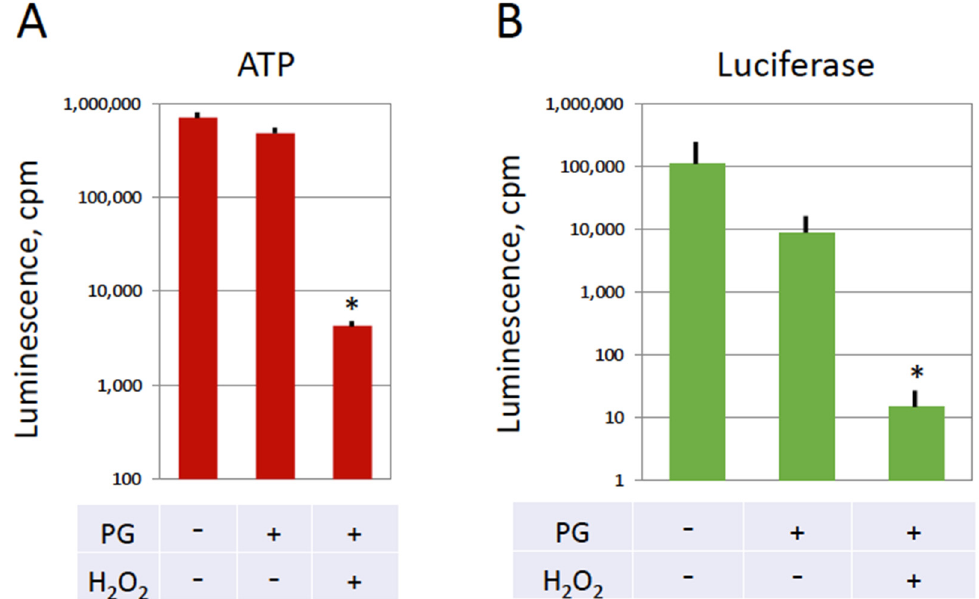
Figure 5. ATP content and protein synthesis in the frog eggs overactivated by oxidative stress. Xenopus oocytes were matured in vitro in the presence of progesterone and incubated in the presence or absence of hydrogen peroxide. Panel ( A ) shows the content of intracellular ATP in the overactivated eggs treated with 10 mM hydrogen peroxide for one hour and peroxide ‐ untreated frog oocytes (PG − ) and eggs (PG+), as evaluated by a chemiluminescent assay (see Section 2, “Materials and Methods” for details). Panel ( B ) presents the intensity of a luminescent signal generated by the luciferase protein synthesized in the oocytes and eggs after injection of luciferase mRNA. The luciferase reporter mRNA was microinjected into the cells immediately before hydrogen peroxide administration. Four to six oocytes or eggs were examined under each condition of treatment. Asterisks denote statistical difference ( p < 0.05) from untreated control oocytes (PG − , H 2 O 2 − ).